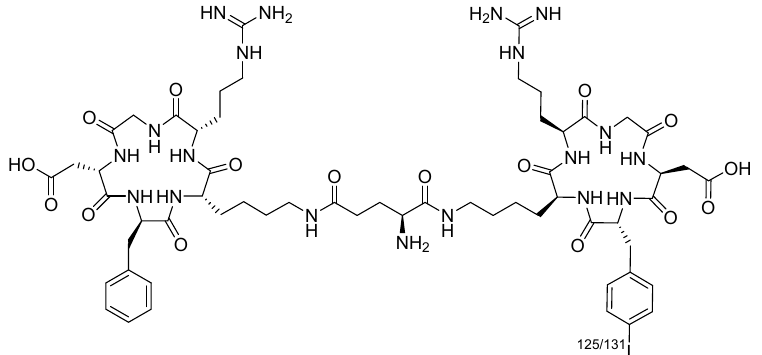
Figure 1. A chemical structure of [ 125/131 I] 6 .